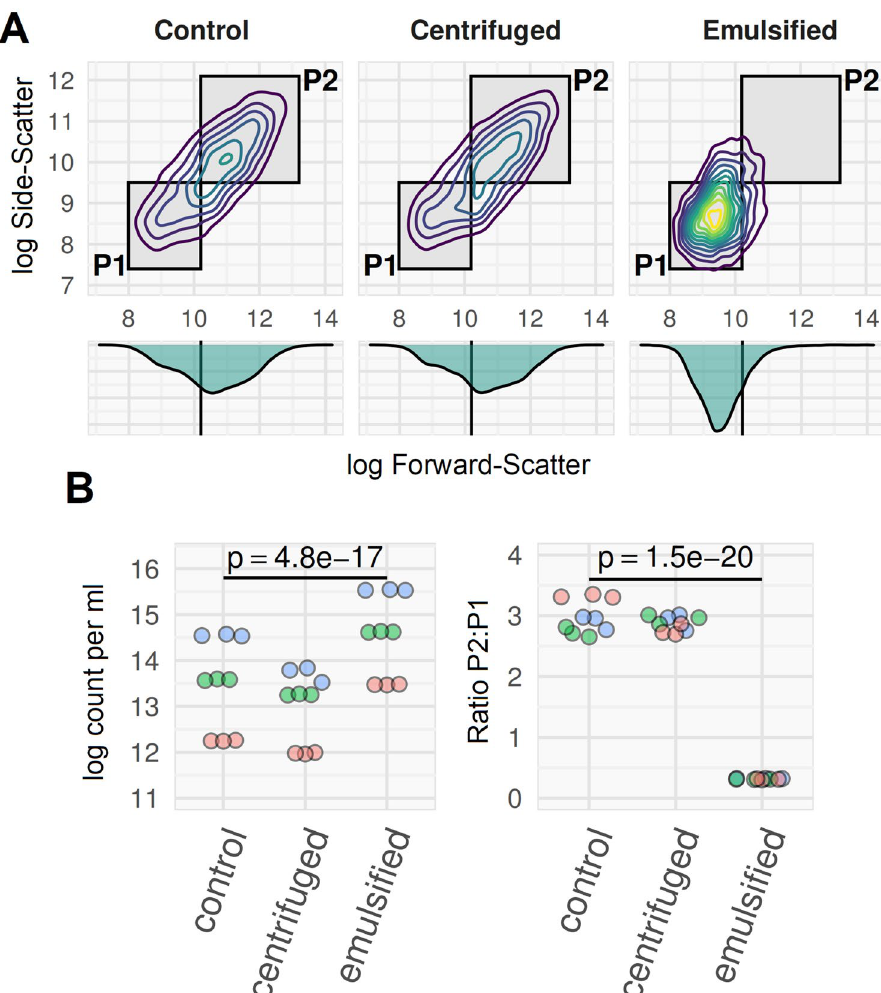
Figure 5. Ratio of clumped to single-cell M. smegmatis is not altered by low- g centrifugation. Three mid-log phase M. smegmatis cultures grown in 0.05% Tween80 7H9 with continuous agitation at 150 rpm (3 biological replicates shown in blue, green and red), processed three ways. Control sample: 10 –1 dilution in 0.1% Tween80 PBS, no physical disruption. Centrifuge sample: 10 ml + 5 ml 0.1% Tween80 PBS; spun in 15 ml centrifuge tubes at 120 × g for 8 min with no brake. Emulsified sample: 10 –1 dilution in 0.1% Tween80 PBS, 12 × needle emulsified. Supernatant used for counts, as per ref 42 main manuscript. All samples heat-killed and stained with SYBR-gold prior to flow cytometry on BD Accuri-C6, with thresholding on SSC and FL1. Data are for three technical replicates of each culture. ( A ) Qualitatively, the FSC by SSC flow plots were similar for centrifuge method and control, compared to the needle-emulsified sample where the cell-clump population (P2) was not evident. ( B ) The ratio of clumps to single cells (p2:p1) was the same in the control and centrifuge preparations, but was much lower (and with less variation across replicates) with emulsification. Apparent cell counts were lower with centrifugation (owing to loss of cells in pellet) and higher with emulsification (owing to disruption of clumps). Three independent culture replicates (read, blue, and green; each processed 3 times in each condition for technical replicates); p -values from repeated measures ANOVA (technical replicates nested within culture